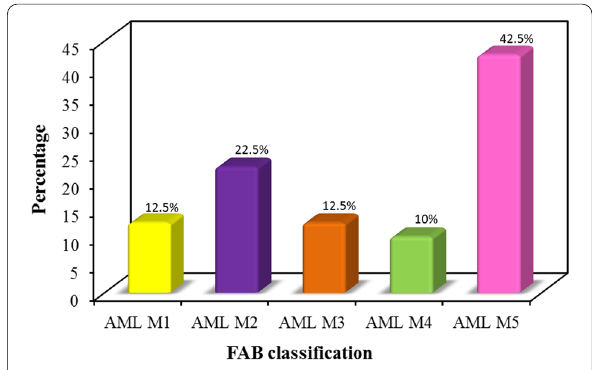
Fig. 1 Distribution of the AML patients according to FAB classification ( n =